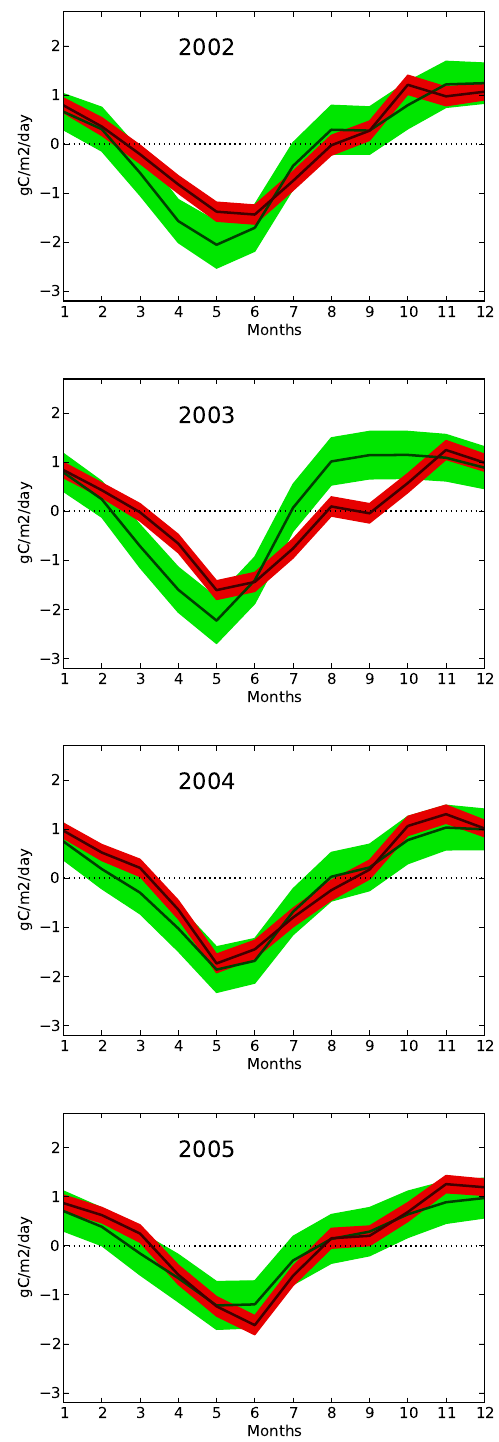
Fig. 3. Temporal evolution of monthly (i.e., 30-day mean) NEE (gCm − 2 day − 1 ; negative values: sink) over the whole European domain of CHIMERE. Green: ORCHIDEE; red: inverted fluxes; shaded areas: NEE ± standard deviation of the uncertainty in NEE. Dotted lines: NEE ± standard deviation of the variations of NEE for a given month from 2002 to